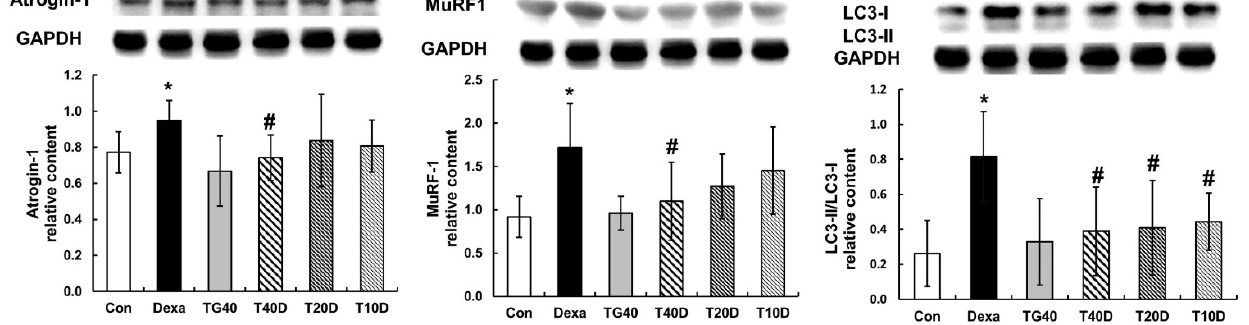
Figure 6. Effects of teaghrelin on three major proteins involved in muscle protein degradation in Dexa-treated rats. At the end of experiment, the contents of Atrogin-1, MuRF1 and LC-3 were measured in the gastrocnemius muscles of Dexa-treated rats by Western blotting. GAPDH was used as a loading control. The Con, Dexa, TG40, T10D, T20D and T40D groups are defined in Figure 1. The results were analyzed using one-way ANOVA. Values are presented as the mean ± SD (n = 5 or 6). * p < 0.05 versus Con; # p < 0.05 versus Dexa.